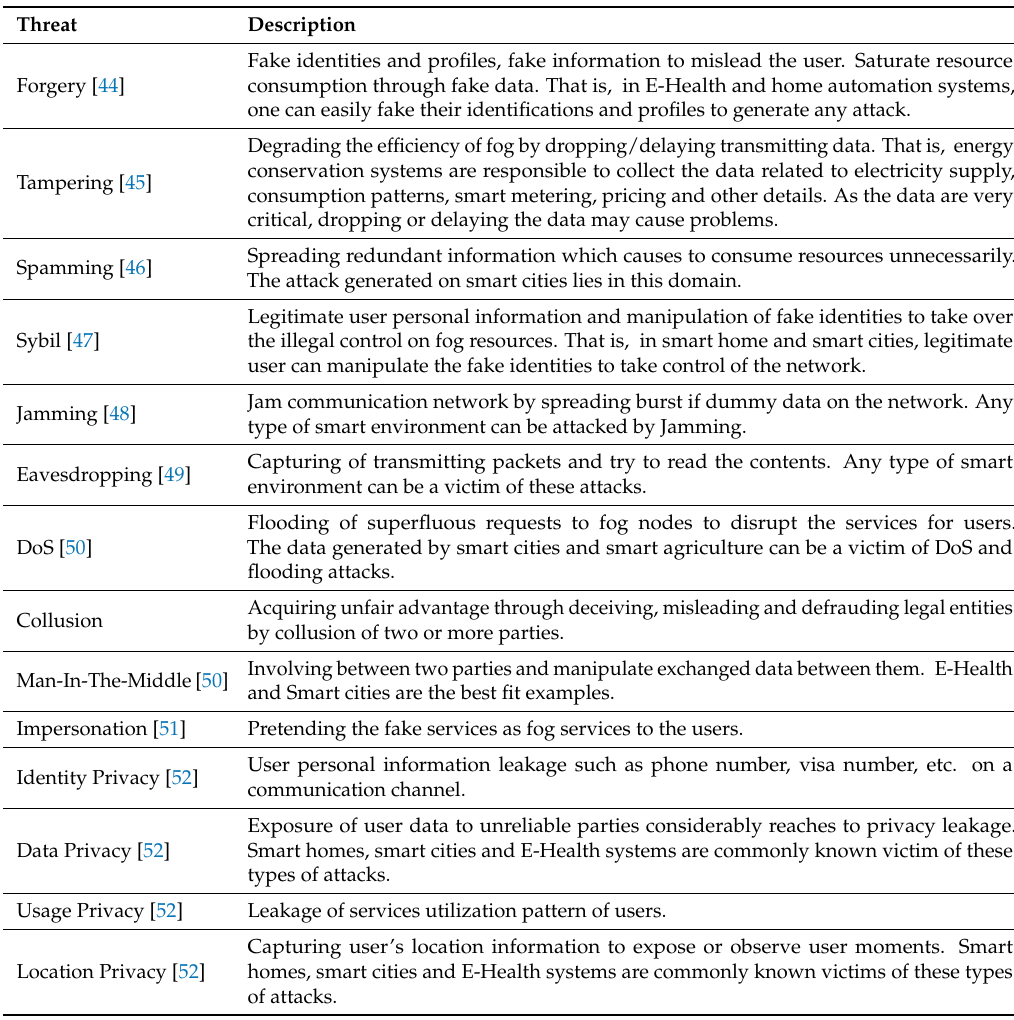
Table 1. Security and privacy threats in IoT-enabled